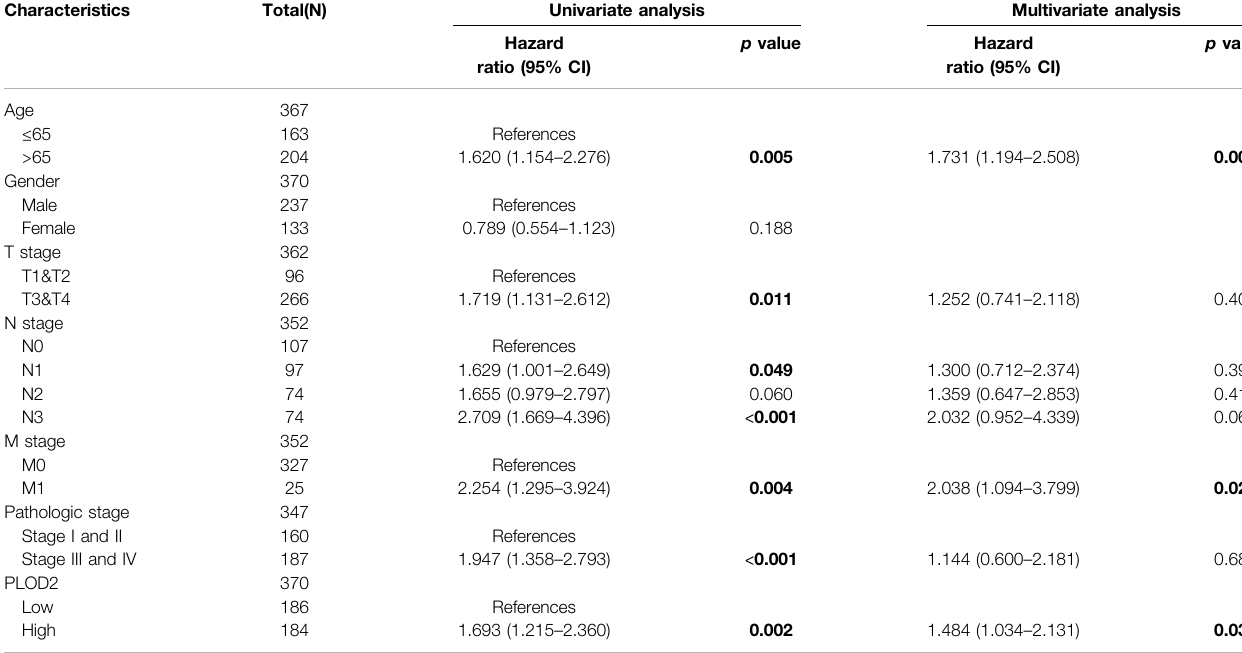
TABLE 1 | Univariate and multivariate Cox regression analysis of overall survival.